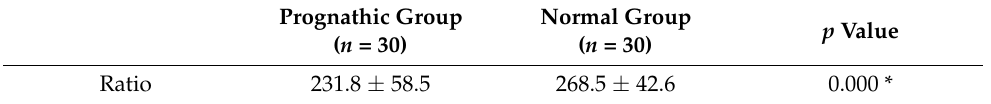
Table 1. Lateral pterygoid volume/length ratios for prognathic and normal groups.